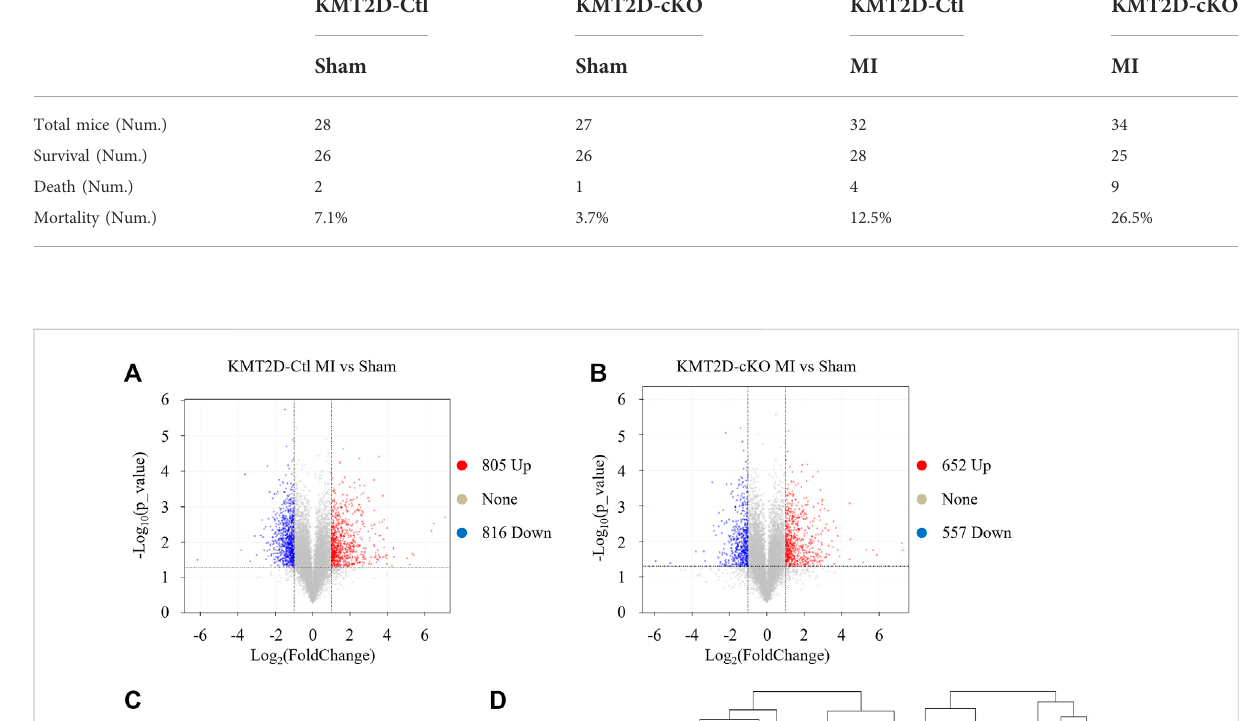
TABLE 1 Mortality statistics of mice within 24 h of ischemia. KMT2D-Ctl KMT2D-cKO KMT2D-Ctl KMT2D-cKO Sham Sham MI MI